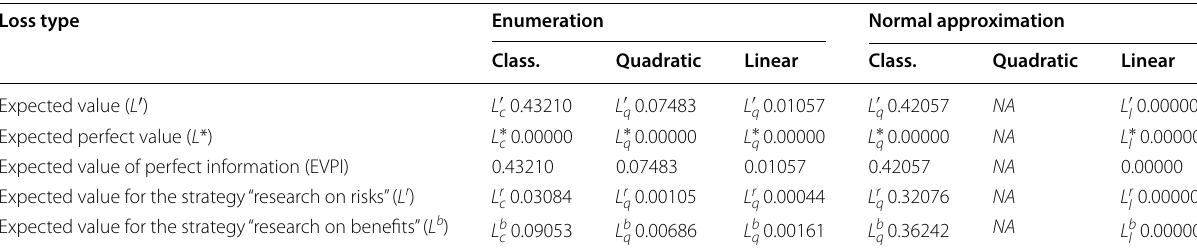
Table 2 Expected values (i.e., losses)